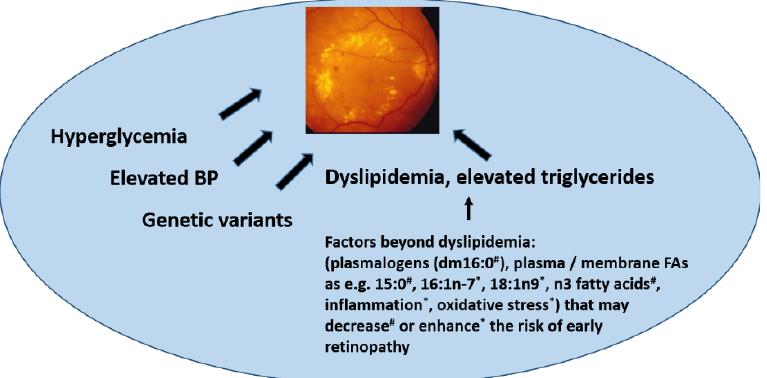
Figure 2. Factors associated with the development of retinopathy. BP: blood pressure FA: fatty acids. With symbols are the proposed factors we find associated with retinal microaneurysms occurrence in the present study (# positively associated; * negatively associated).